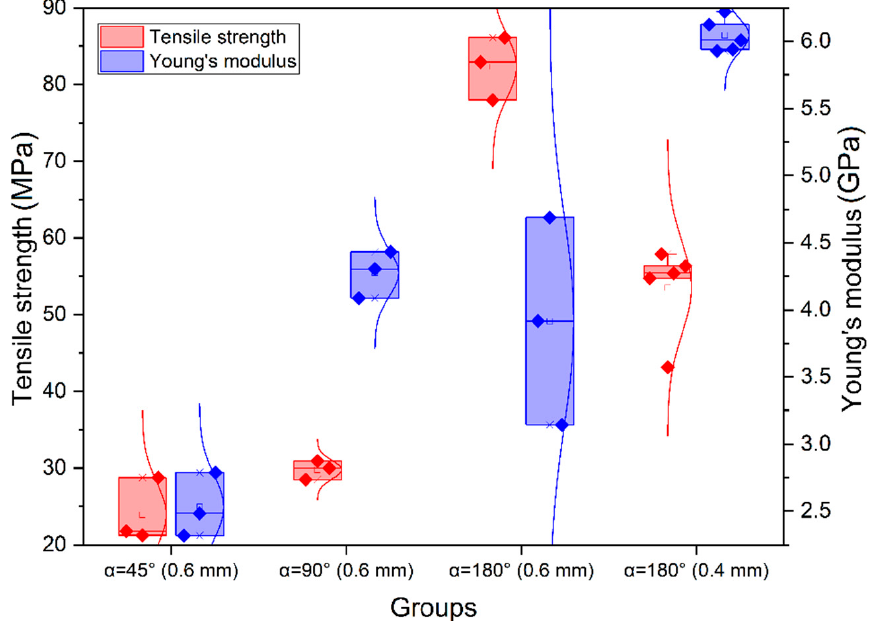
Figure 6. Results for tensile strength and elastic modulus of samples without heat treatment for α = 45°, α = 90° and α = 180° (nozzle diameter is given in brackets).